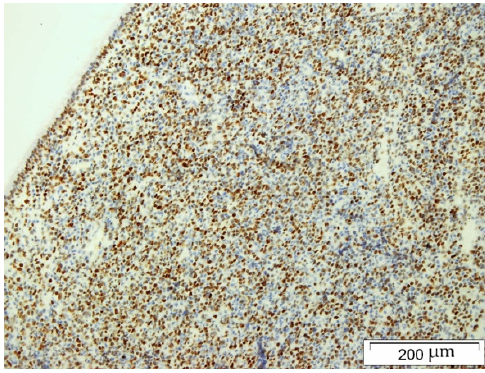
Figure 5. Tumor biopsy: CD20 staining.